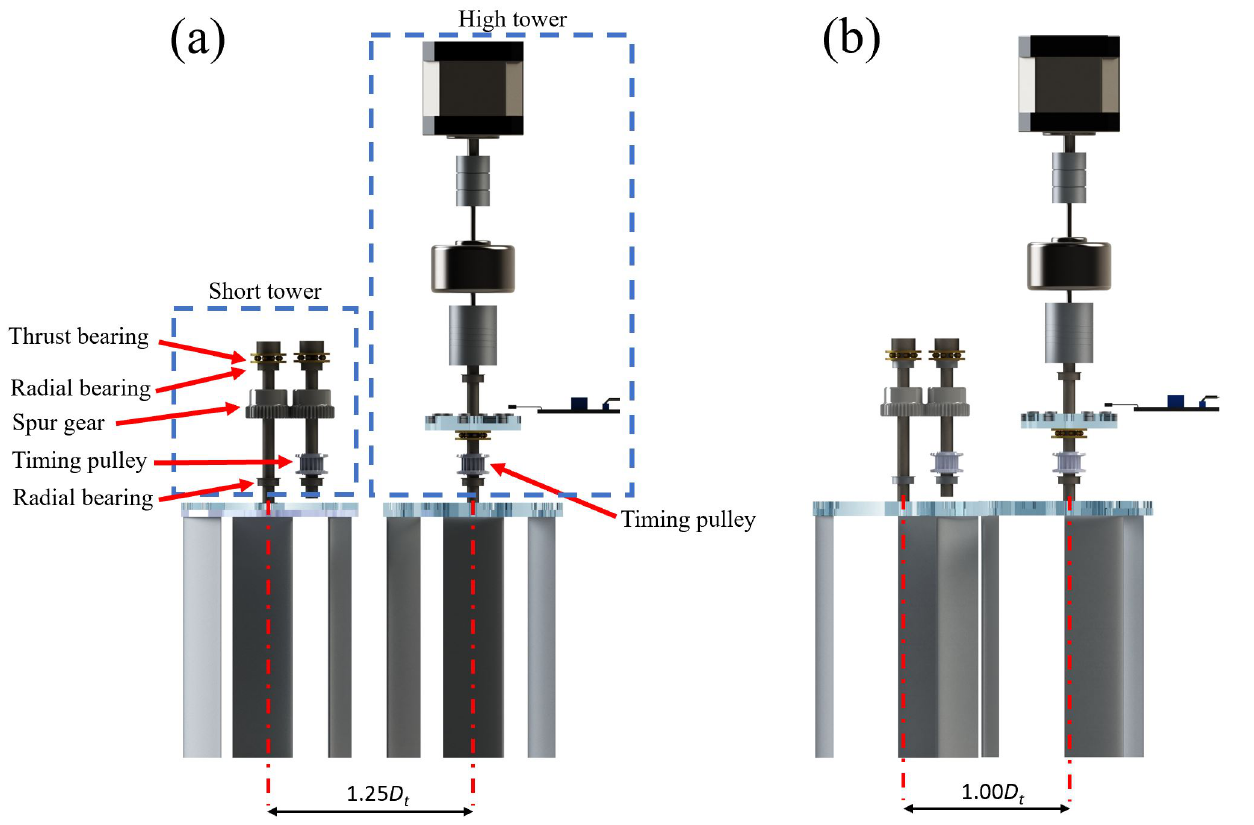
Figure 1. An illustration of the twin turbine apparatus variations: ( a ) counter-rotating and ( b ) overlapping turbines with the separation distance of 1.25 D t and 1.00 D t . The figure was adapted from [10].